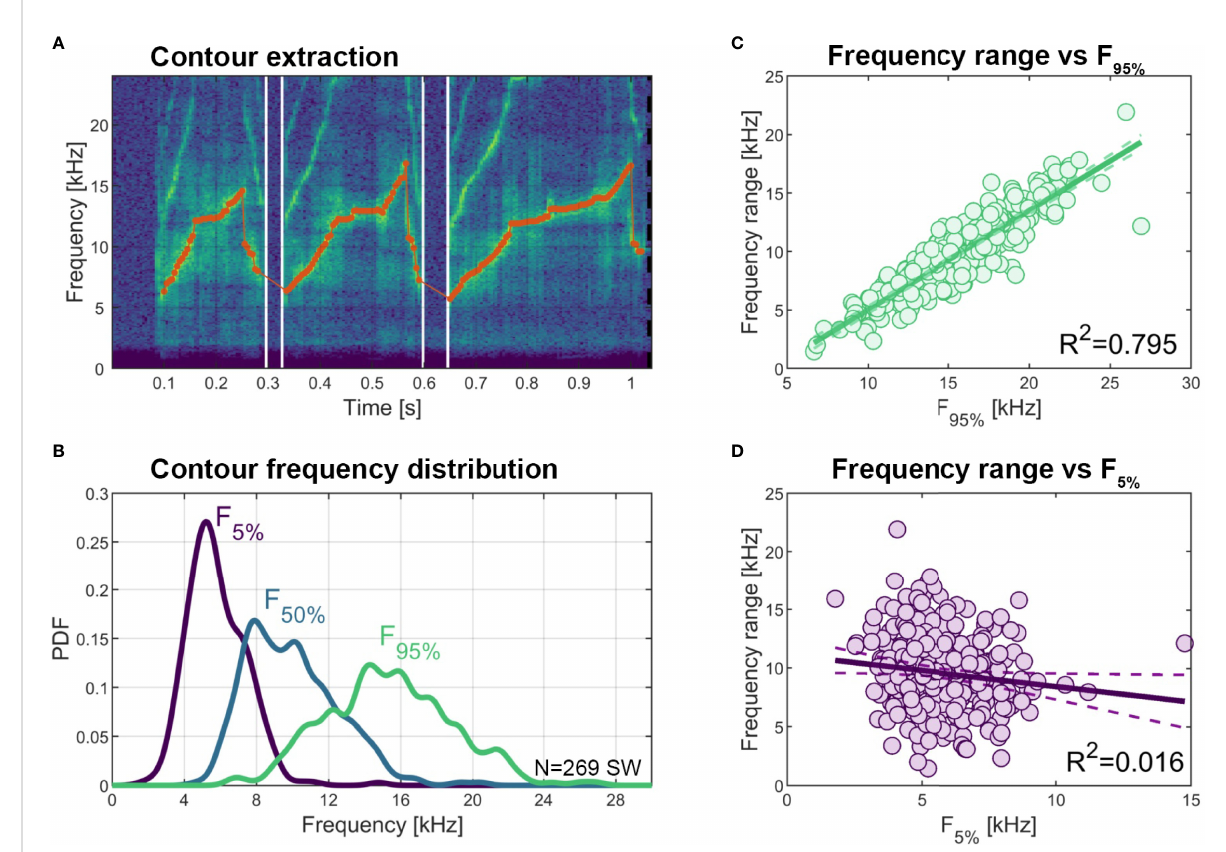
FIGURE 7 Variation in signature whistle contour frequency parameters. (A) Example spectrogram of a signature whistle with extracted fundamental frequency contour overlaid (red dots, 5 ms resolution). (B) Distribution (PDF: power density function) of lower 5 th percentile, 50 th percentile (median), and upper 95 th percentile contour frequency across all 269 signature whistles. (C) Correlation between upper 95 th percentile contour frequency and contour frequency range (calculated as the difference between 95 th and 5 th percentiles). (D) Correlation between lower 5 th percentile contour frequency and contour frequency